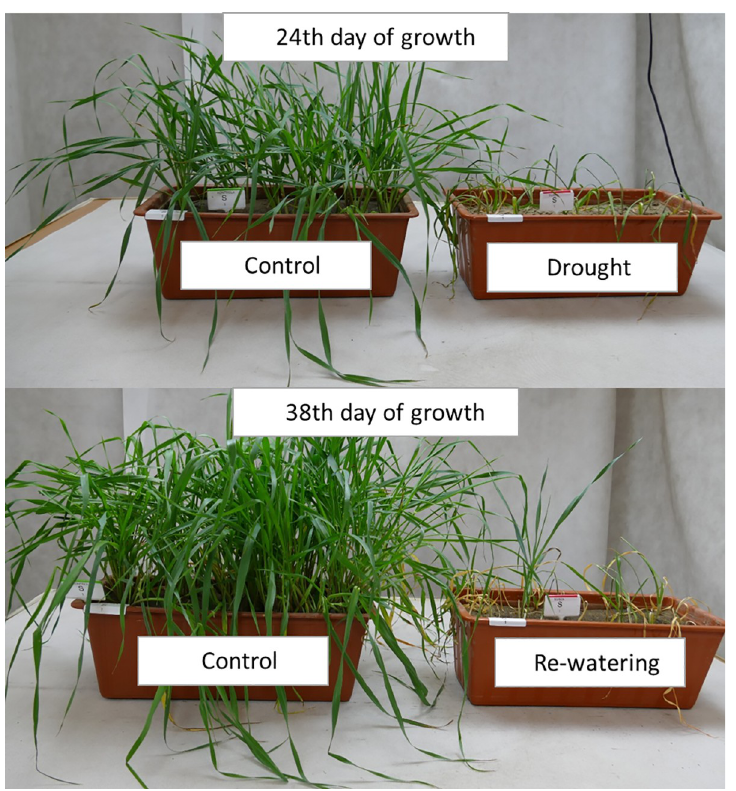
Fig 5. Phenotypes of ‘Sebastian’ seedlings during drought assay under control growth (CG) and after 14 days of drought stress (DS) on 24 th DAS; under CG and after 14 days of re-watering (RW) on 38 th DAS.